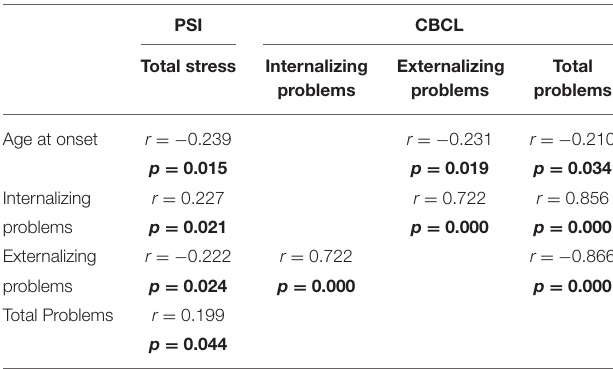
TABLE 3 | Correlation